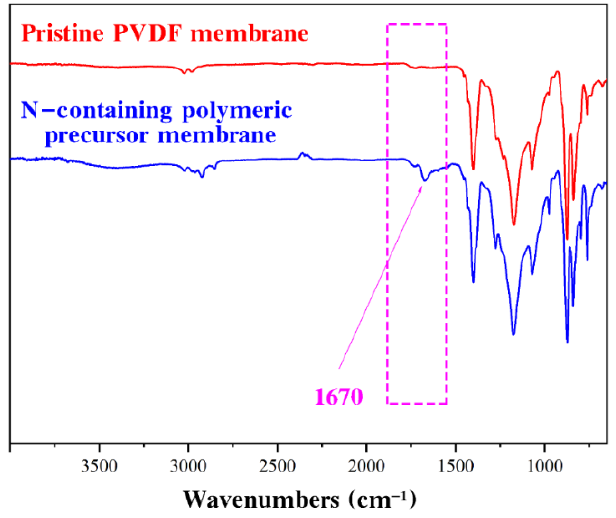
Figure 1. FTIR spectra of pristine PVDF and N-containing polymeric precursor membrane .